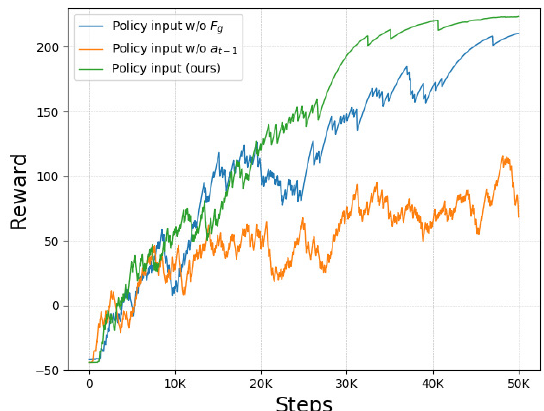
Figure 12. Comparison of policies with different inputs. Learning curve for cuboid-peg insertion task with random initial positions and random desired insertion